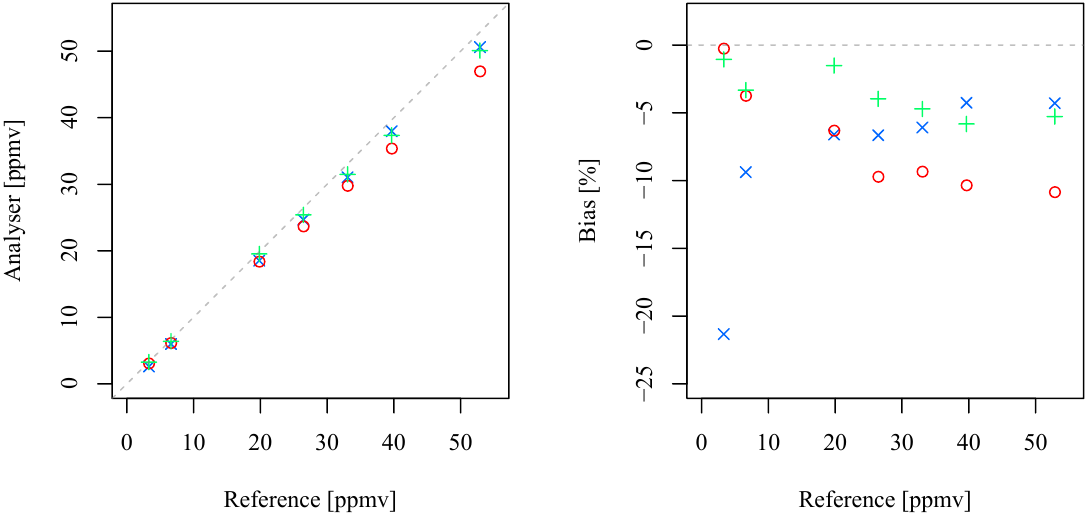
Figure 4. The scatter plot ( left ) and relative bias ( right ) between the generated reference concentrations (diluted from a certified 52.9 ppm v ammonia cylinder with nitrogen) and three gas analyser ( ◦ INNOVA, + Rosemount, × Axetris) measurements on ammonia (NH 3 ). The dashed line denotes 1:1